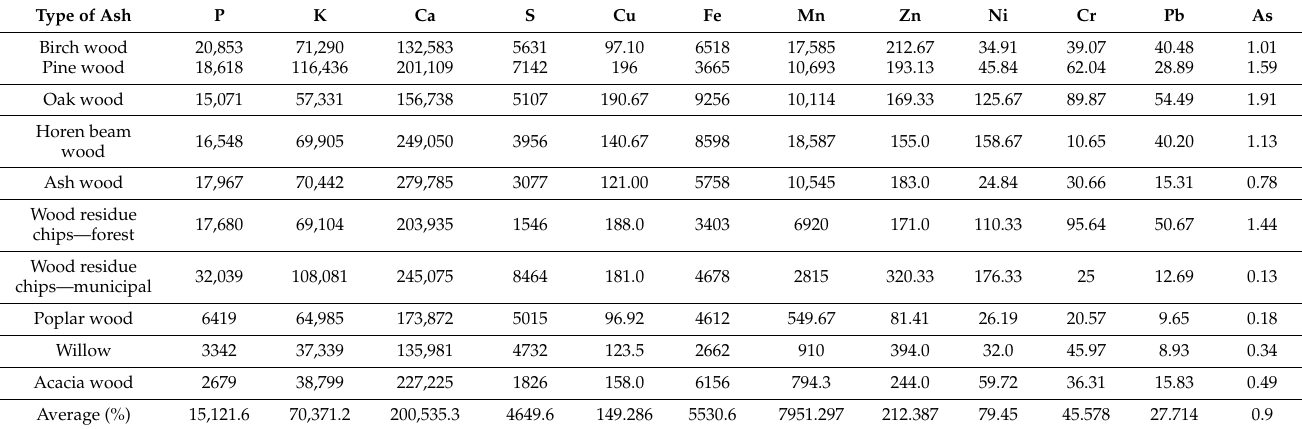
Table 1. Chemical elements of the ashes (ppm)